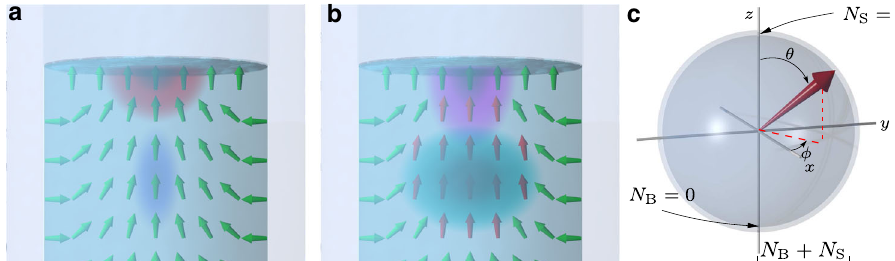
Fig. 2 Time crystal two-level system. a The distribution of L (green arrows) con fi nes magnons in two local minima, hosting two adjacent time crystals: one in the bulk of the super fl uid (blue blob) and the other one touching the free surface (red blob). In each time crystal, magnetisation is precessing coherently, which couples to measurement circuitry as shown in Fig. 1. b Magnons in the bulk modify the con fi ning trap created by the L distribution. When the bulk population is large (cyan blob), the textural trap is widened (red arrows), which modi fi es also surface time crystal ’ s wave function (magenta blob). This increases the coupling between the states. Changes in the trap and the wave functions have been exaggerated for illustrational purposes. c The state of the two-level system (red arrow) can be illustrated using a Bloch sphere where radial distance corresponds to magnon number N B + N S , the relative phase between the time crystals ’ precession corresponds to the azimuthal angle ϕ , and the polar angle θ describes the relative weights of the two-level basis states in the “ superposition ” (see Methods).